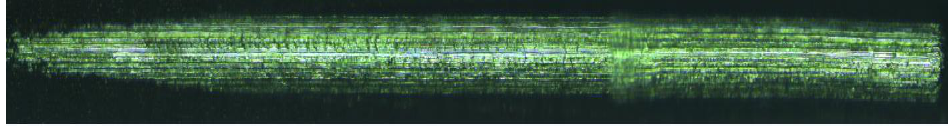
Figure 11. Surface topography after scratch testing.